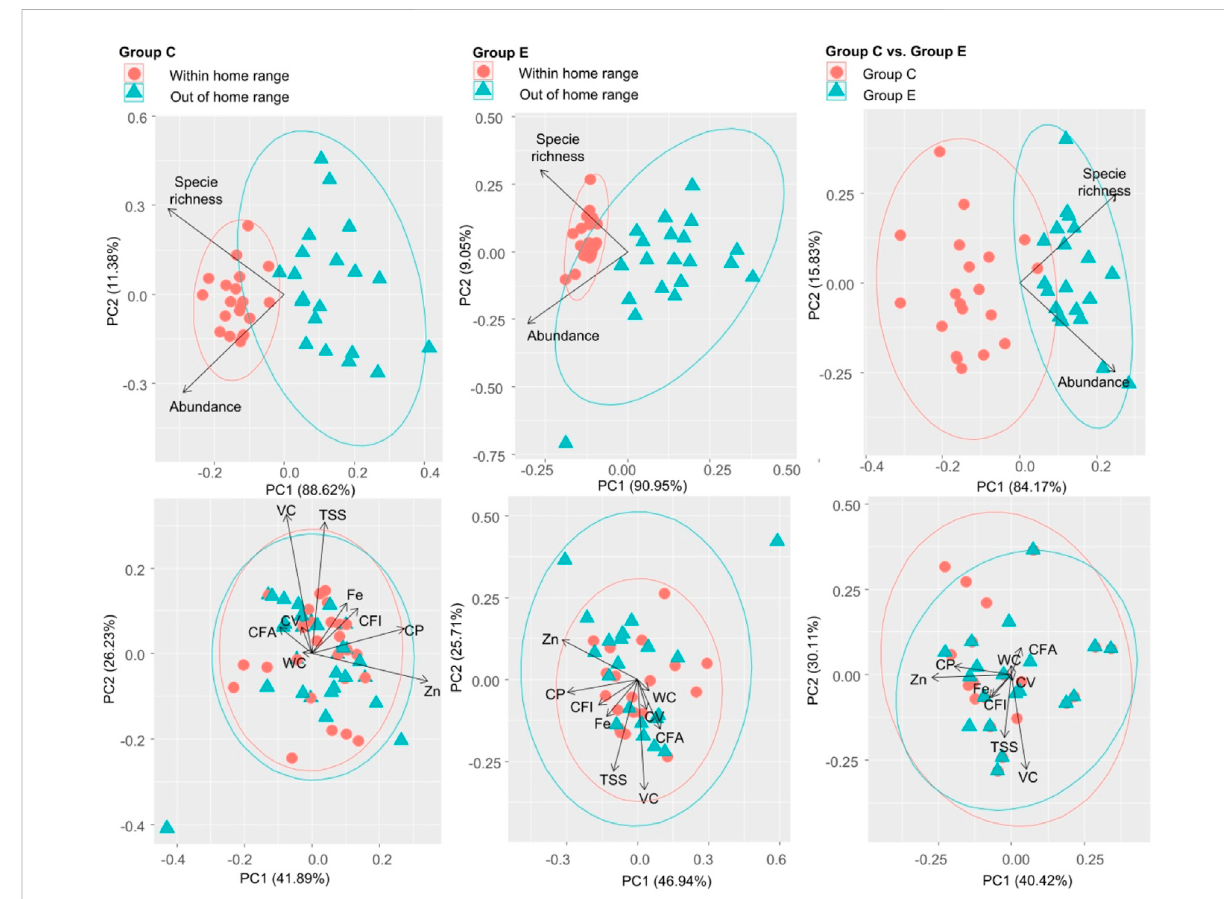
FIGURE 6 Principal component analysis of food plant diversity (richness and abundance) and CWM for nine food plant leaf nutrient traits between within and out of the home range in groups C and E and between the home range of groups C and E. These nine traits include leaf water content (WC,